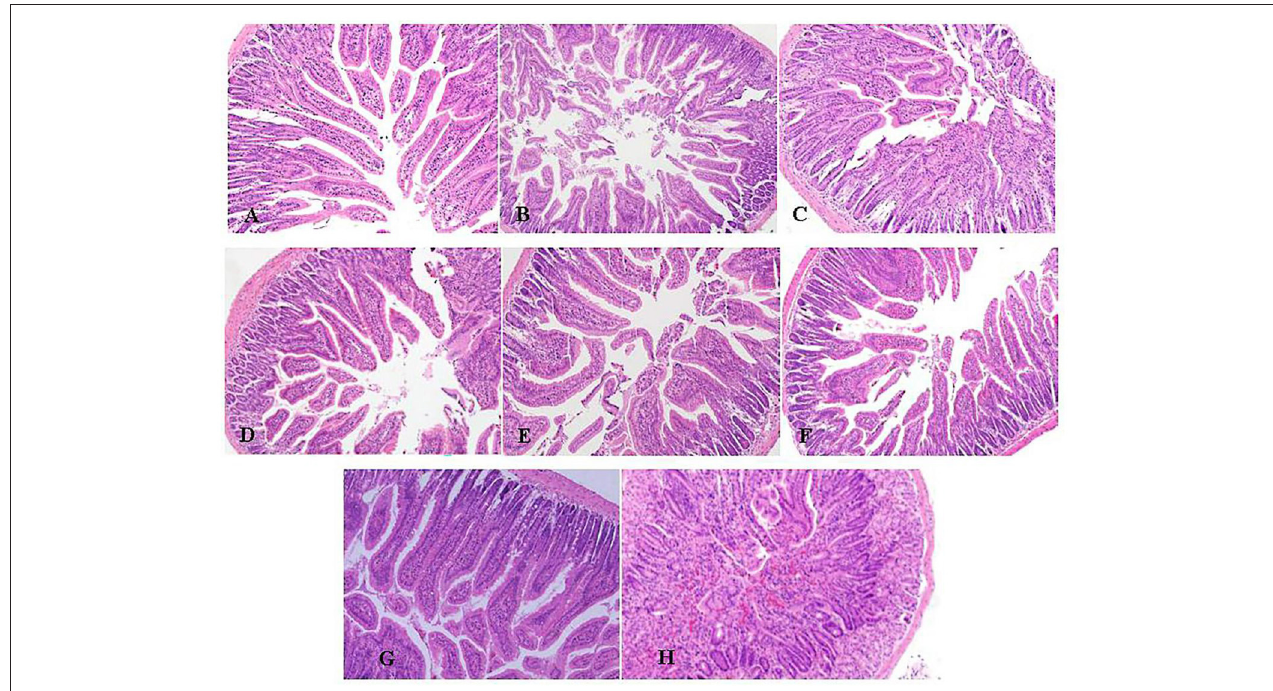
FIGURE 2 | Effects of varying doses of LEO (A–C) or DEO (D–F) from 300, 600 to 1,200 mg/kg BW on pathological of H&E stained duodenum (100 × ) in E. coli -infected mice (A–C) . (G) : NS group. (H) : E. coli group. LEO, lemon essential oil; DEO, d-limonene essential oil.